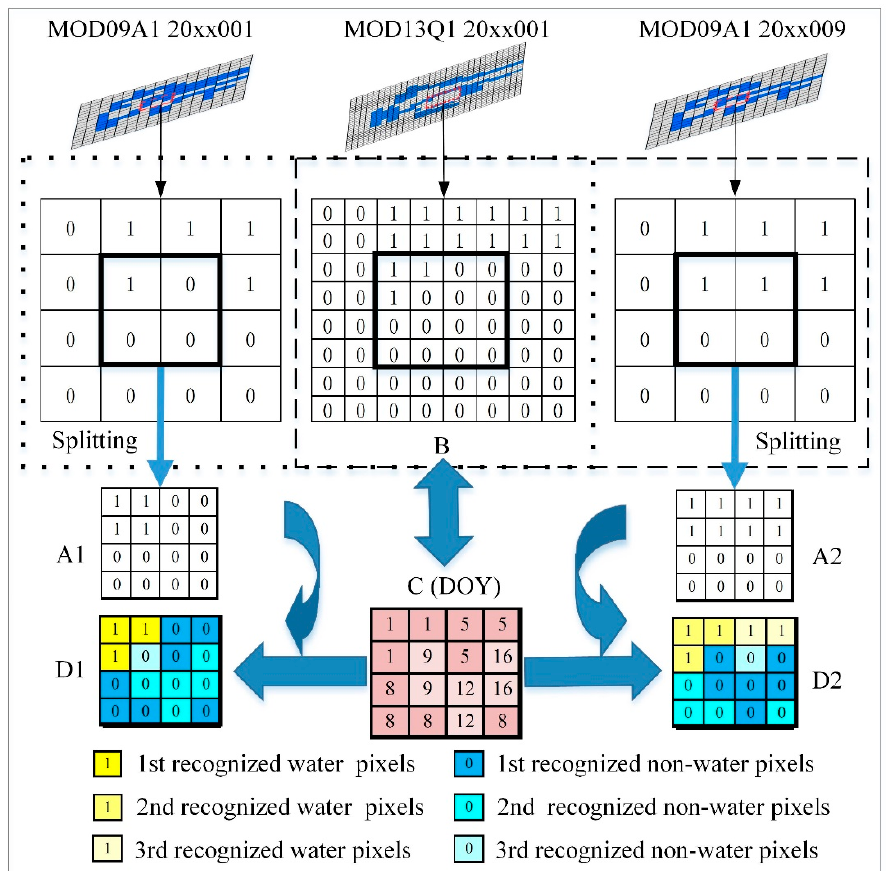
Figure 5. Fusion schematic of two sets of water results within 500 m every eight days and 250 m every 16 days for the window 3 × 3 (source: Rao et al. [18]).